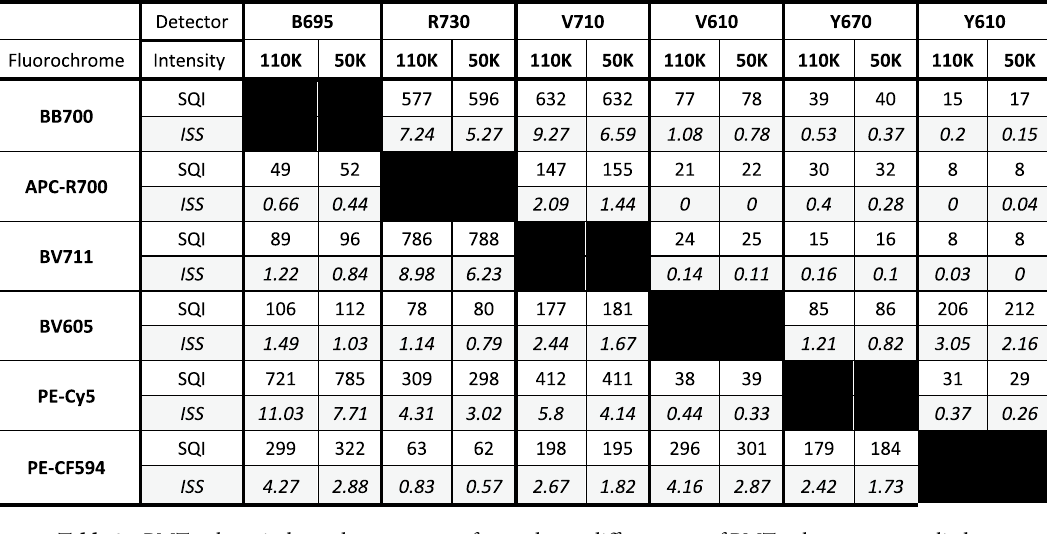
Table 3. PMT voltage independent measure of spread: two different sets of PMT voltages were applied to set the MFI of the positive population to 110,000 (110 K) or 50,000 (50 K). ISS values are shown in Italics. Six single stained bead samples were run using these two voltage sets, and the ISS and SQI values were calculated. The SQI values were similar at the different voltages, whereas the ISS values were voltage different. ISS values are shown in Italics.